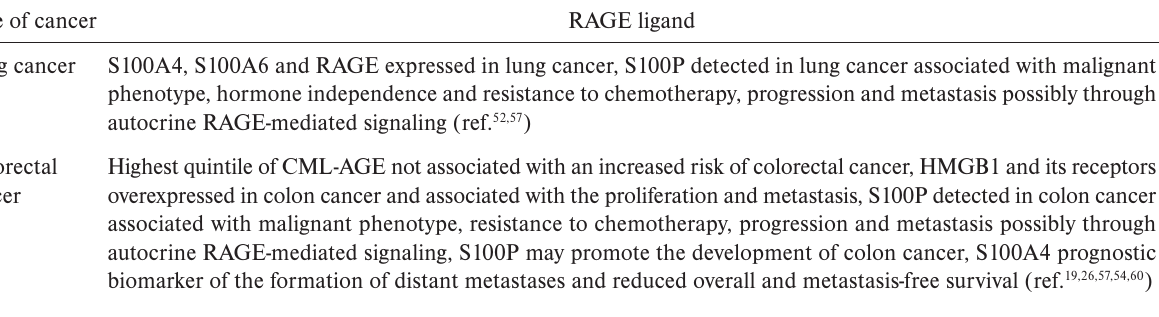
Table 1. Types of cancer associated with RAGE ligands and their putative